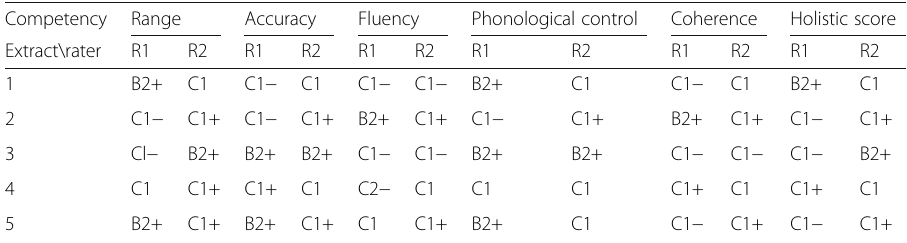
Table 3 Examples of rating results by Raters 1 and 2 Competency Range